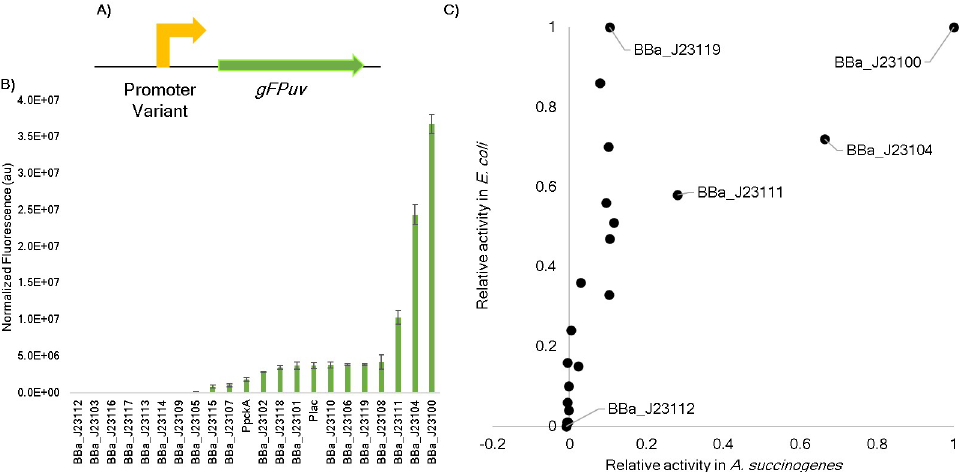
Fig 2. Characterization of 22 constitutive promoters in Actinobacillus succinogenes 130Z. (A) Schematic of SSBIO-SA001 expression system. (B) GFPuv expression normalized by absorbance and background control (Materials and Methods). Error bars represent one standard deviation. (C) A comparison of relative expression of the Anderson promoters in A . succinogenes and E . coli . For both bacteria, relative expression was calculated by dividing all values by normalized expression from the strongest promoter